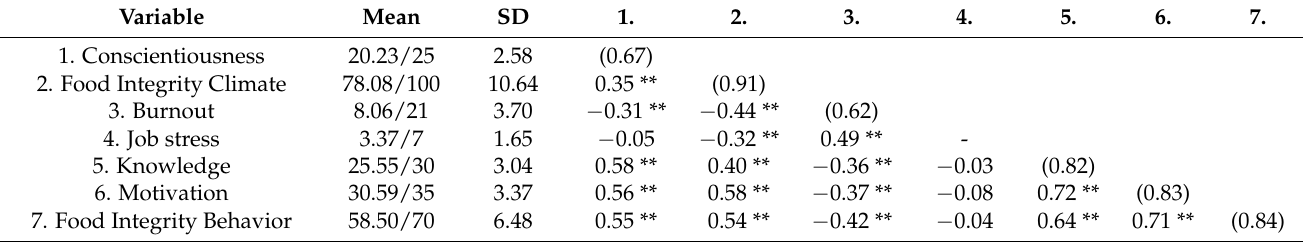
Table 2. Univariate analysis of continuous study variables and bivariate correlation matrix of continuous study variables ( n = 118 participants). Internal Consistency Reliability ( α ) is shown in the diagonal (** p < 0.01) (/ = out of) (SD = standard deviation). Food integrity behavior was found to have a significant positive relation with conscientiousness, food integrity climate, food integrity knowledge and food integrity motivation, a significant negative relation with burnout and no significant relation with job